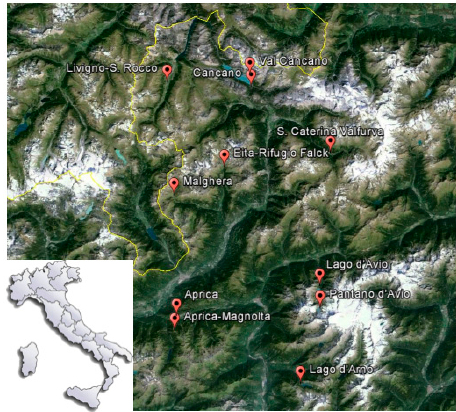
Figure 2. Map of the sites selected for the error estimate for solid precipitation measurements through precipitation gauges in the upper Valtellina and upper Valcamonica, in Northern Italy.